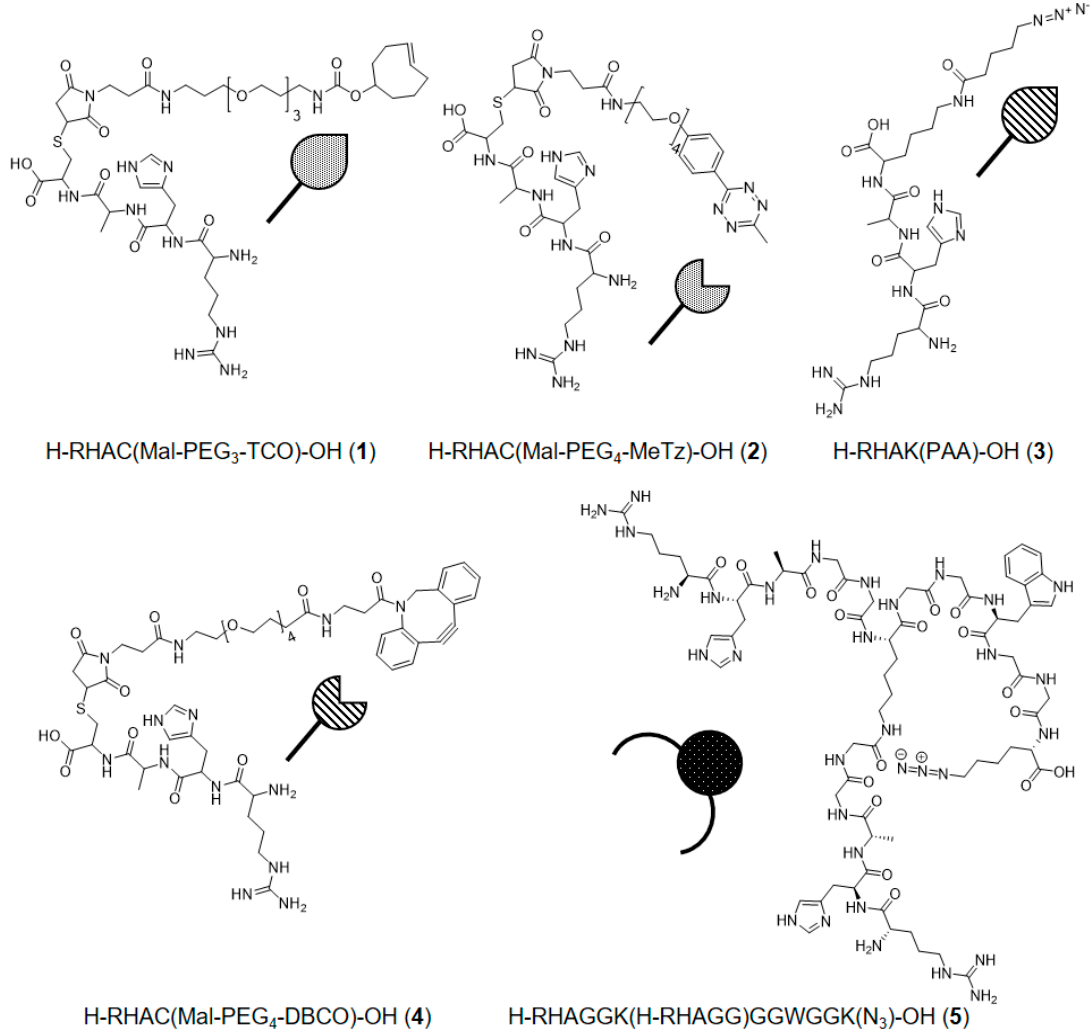
Figure 1. Structures of click linkers used. H-RHAC(Mal-PEG 3 -TCO)-OH ( 1 ) and H-RHAC(Mal-PEG 4 -MeTz)-OH ( 2 ) were used for IEDDA; H-RHAK(PSA)-OH ( 3 ) and H-RHAC(Mal-PEG 4 -DBCO)-OH ( 4 ) were used for SPAAC; H-RHAGGK(H-RHAGG)GGWGGK(N 3 )-OH ( 5 ) was used for enzymatic C - to C -terminal Fab coupling. Mal: maleiimide, TCO: trans -cyclooctene, MeTz: methyltetrazine, PAA: pentanoic acid azide, DBCO: dibenzocyclooctyne.